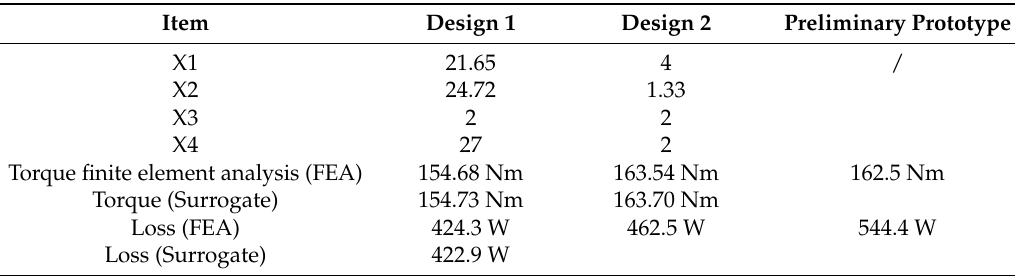
Table 2. Optimized results of the two rotors.